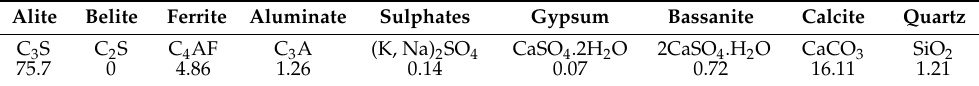
Table 6. Mineral composition of the Portland